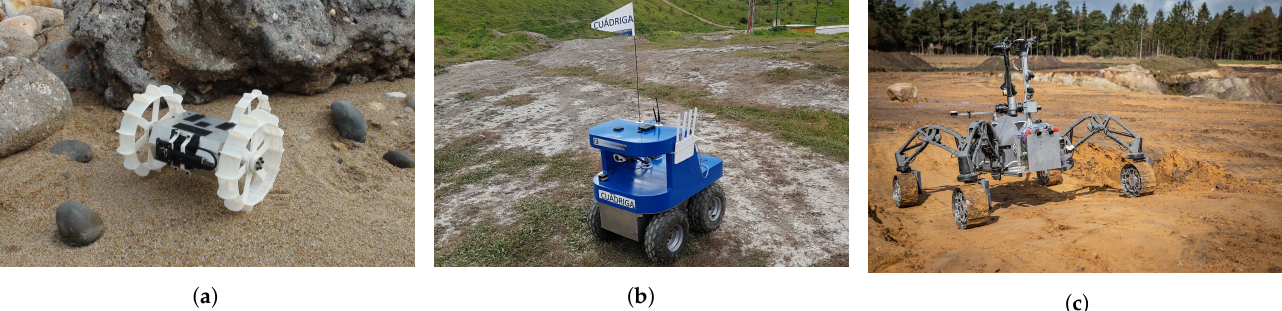
Figure 3. Examples of ground mobile robots with different kinematic configurations. The Koguma rover ( a ) has Differential Drive locomotion. Cuádriga ( b ) is a Skid-steering robot owned by our institution, the University of Málaga. SherpaTT ( c ) has four steerable wheels that allow it to execute Full Ackermann , Crabbing and Point Turn maneuvers. ( a , c ) have been reproduced with permission of the University of Tohoku and the German Research Center for Artificial Intelligence (DFKI),